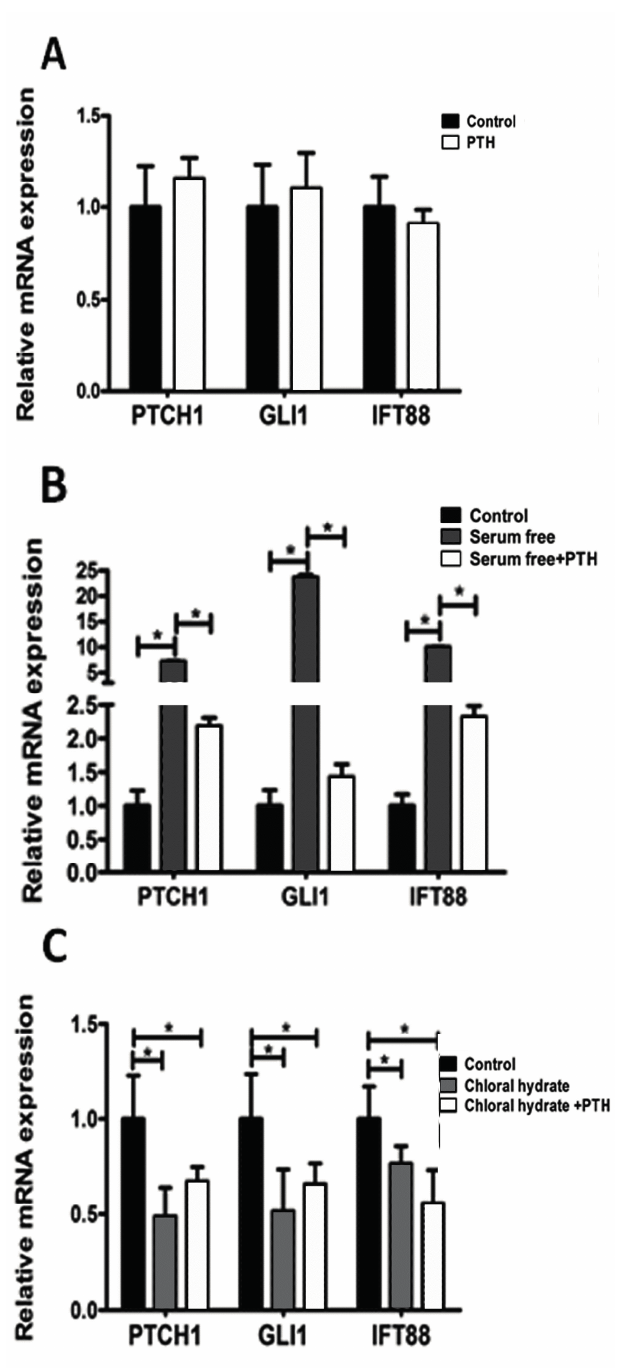
Figure 8. PTH/PTHrP can affect Hh signaling pathway downstream gene